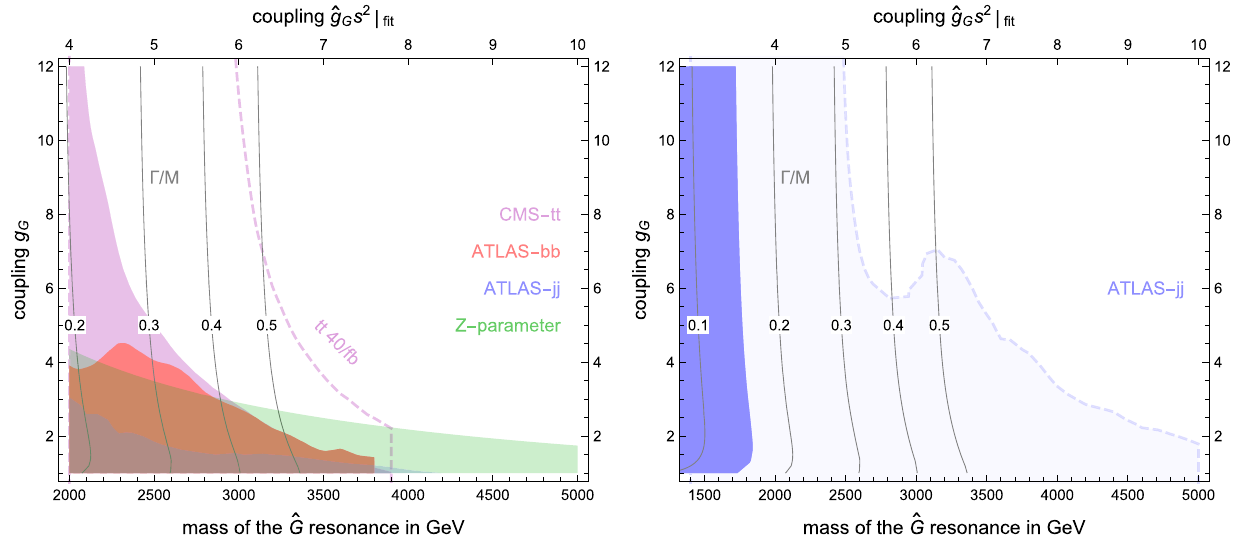
Fig. 3 Limits from LHC searches in the plane ( mG , gG ). The solid / m lines describe (cid:20) ˆ G and the upper axis with are set by requiring G consistency with the fit (see text). Left panel: constraints arising from searches for a resonance decaying t ¯ t [40] with (cid:20) ˆ